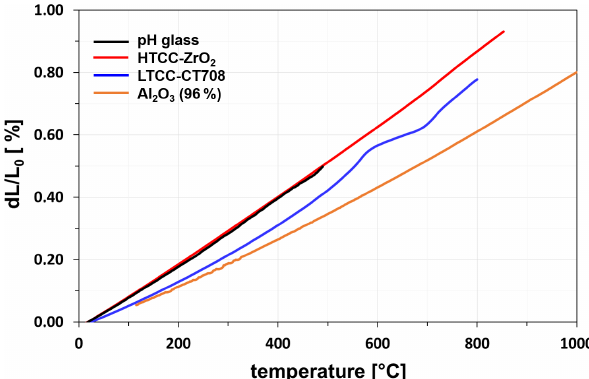
Figure 4. Thermal expansion behaviour of pH glass, HTCC ZrO 2 , LTCC CT708, and Al 2 O 3